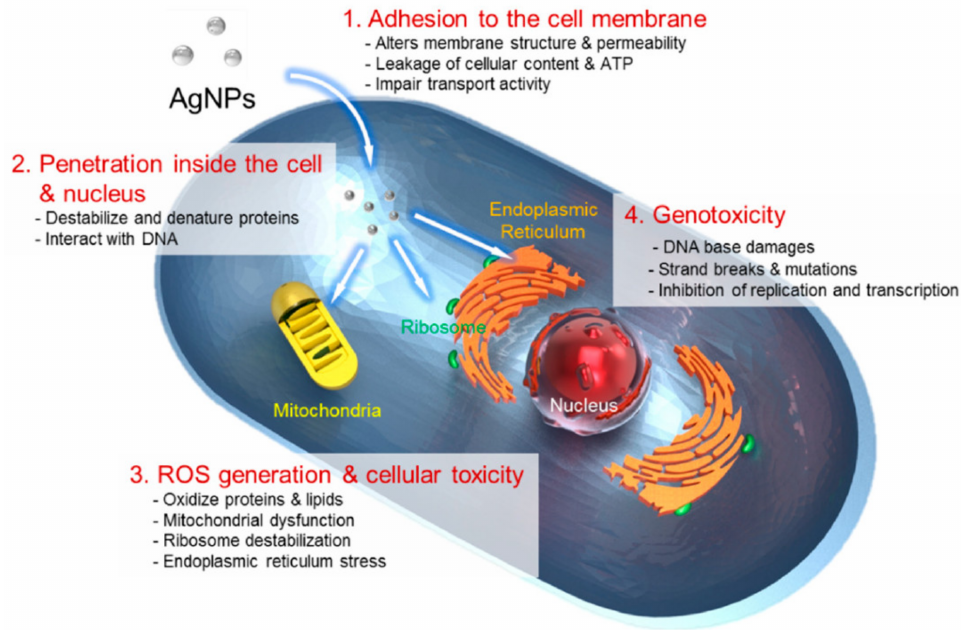
Figure 5. Routes of cytotoxicity action for AgNPs. ( 1 ) Adhesion to cell wall; ( 2 ) Cellular internalisa- tion; ( 3 ) ROS generation; ( 4 ) Genotoxicity. Reprinted with permission from MDPI